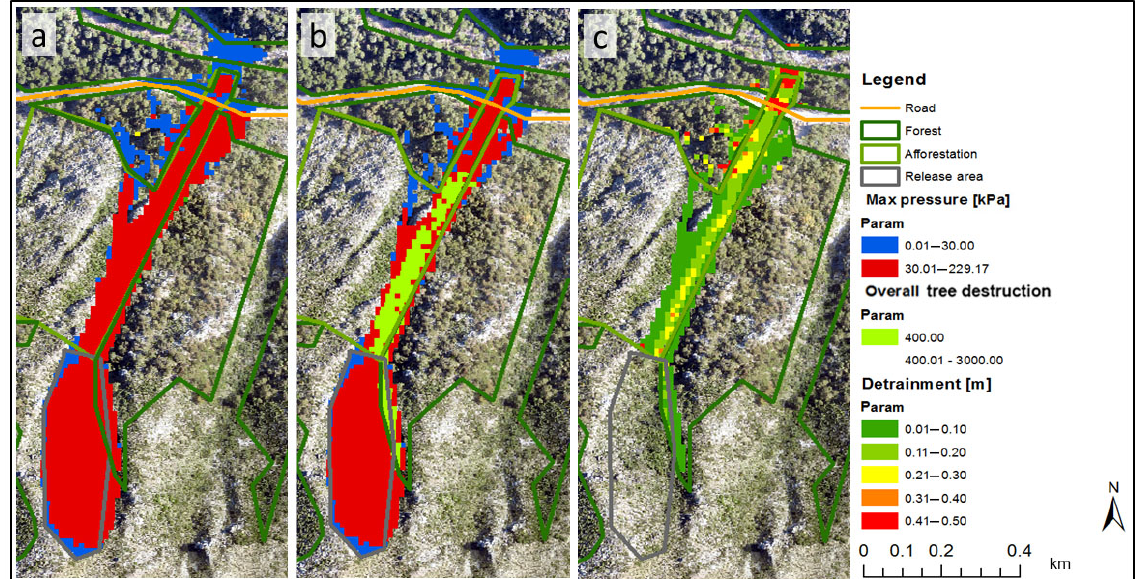
Figure 9. Influence of additional afforestation in avalanche track 6 with a 10-year return period: (a) maximum pressure in an avalanche simulation without additional forests, (b) maximum pressure and overall tree destruction in an avalanche simulation with additional forest and (c) detrainment in an avalanche simulation with additional